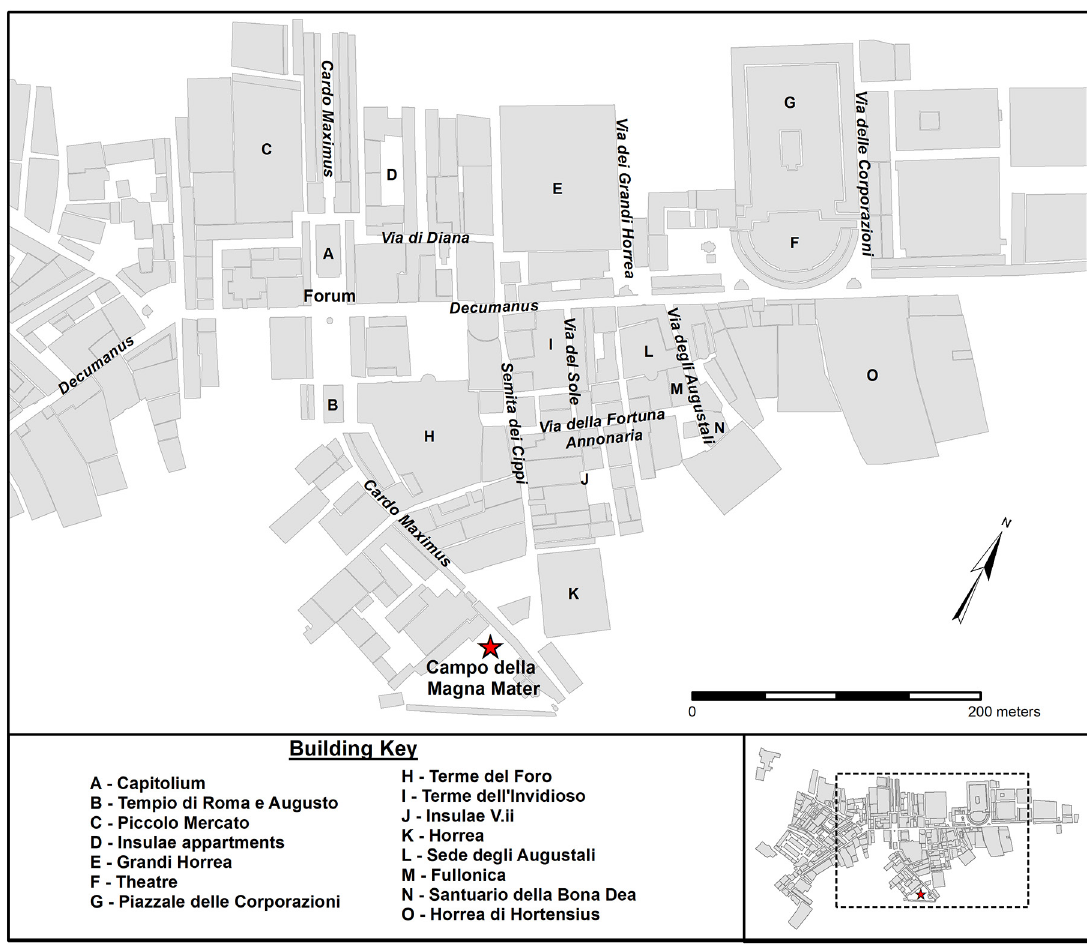
Figure 1. Plan showing important 2 nd century CE streets and buildings surrounding the Campo della Magna